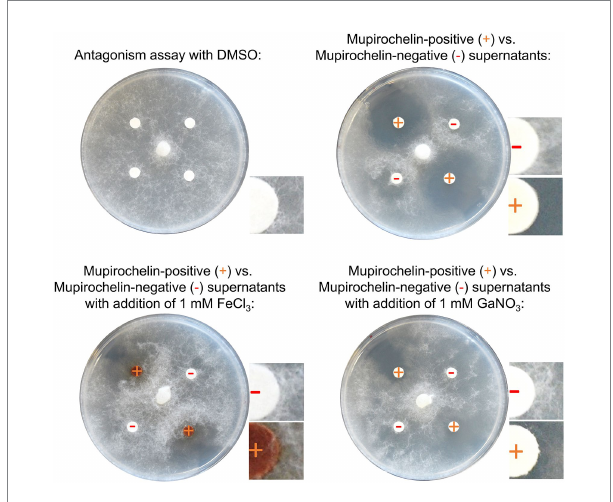
FIGURE 2 Growth inhibitory assays of mupirochelin and its chelated forms with iron and gallium. The growth inhibitory assay is realized with the semi-purified supernatants of 10586 ∆ pvdL ∆ trbABC ∆ mchQ (mupirochelin-positive) and 10586 ∆ pvdL ∆ mchAB ∆ trbABC (mupirochelin-negative) mutants. Samples were prepared with or without the addition of 1 mM FeCl 3 or GaNO 3 and resuspended in DMSO. On the upper-left corner, the control shows that DMSO does not present a growth inhibitory activity against G. ultimum . Apo - mupirochelin is necessary for the inhibition of the oomycete expansion (upper-right corner). However, ferri-mupirochelin has lost most of its activity. On the lower-left panel, the growth of the phytopathogen is slowed down. G. ultimum hyphae are able to progress on the ferri-mupirochelin impregnated disks. The same observation is made for the gallium-mupirochelin